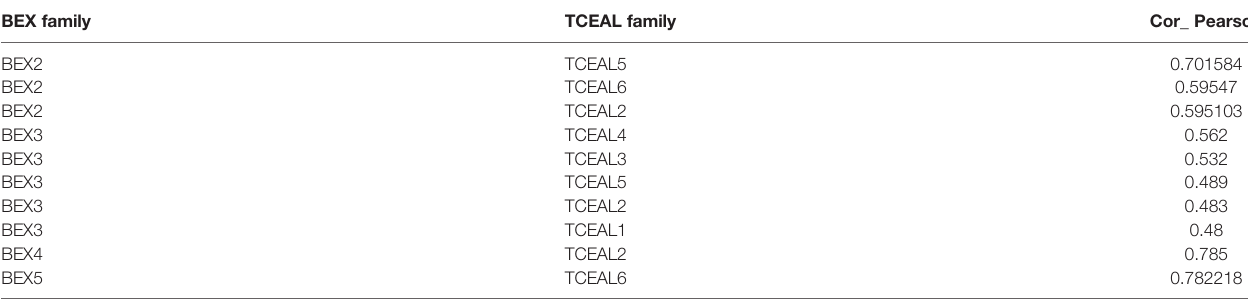
TABLE 2 | There was a signi fi cant correlation between the expression levels of BEX family genes and TCEAL family genes in GBM (Pearson ’ s analysis). BEX